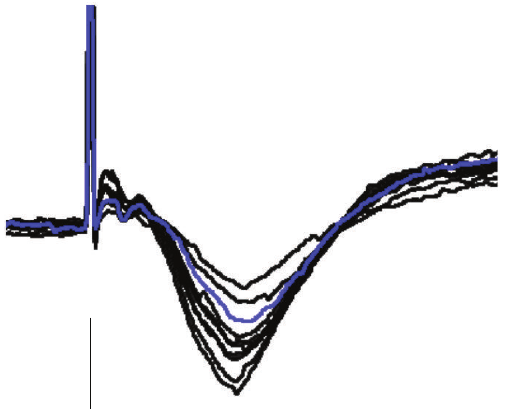
Figure 1: Typical fPSPs recorded in V1 in response to single-pulse stimulation of the ipsilateral LGN in a urethane-anesthetize rat. fPSPs were recorded during input-output stimulation (0.1 to 1.0mA stimulation current); note the increase in fPSP amplitude with increasingstimulationintensities.Thebluetrace(elicitedby0.3 mA) was the intensity used for the subsequent data collection (bottom; calibration bars indicate 0.5 mV vertical and 10ms